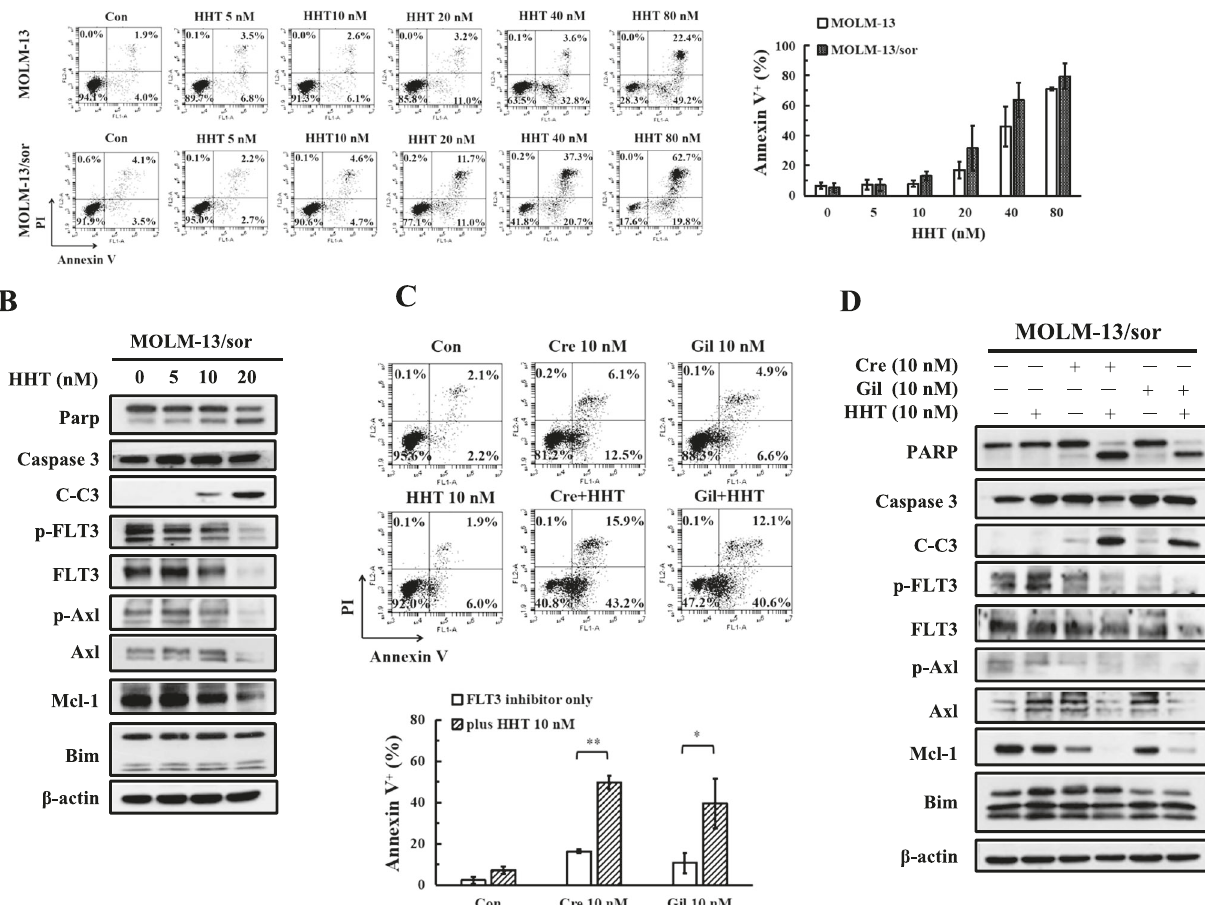
Fig. 5 Apoptosis induction of HHT in combination with crenolanib and gilteritinib in MOLM-13/sor cells. A Apoptosis of MOLM-13 and MOLM-13/sor cells treated with HHT at the indicated concentrations for 24 h and detected by Annexin V/PI staining. B Protein regulation of HHT in MOLM-13/sor cells. C Apoptosis of MOLM-13/sor cells treated with 10 nM HHT plus 10 nM crenolanib or gilteritinib for 24 h detected by Annexin V/PI staining. * P < 0.05, ** P < 0.01 compared with the FLT3 inhibitor group. D Protein regulation of MOLM-13/sor cells treated by HHT plus crenolanib or